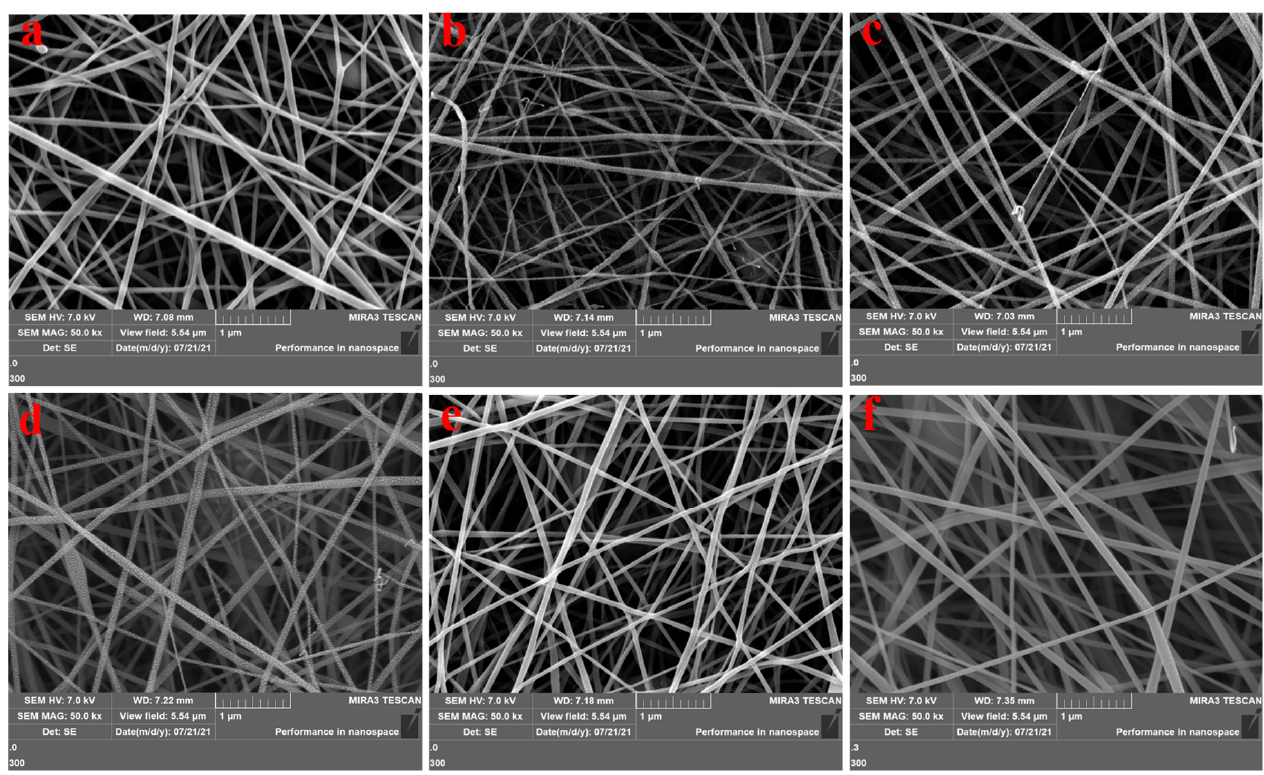
Figure 2. Scanning electron micrographs of flavonoids before sampling of electrospinning membranes ( a ) Chrysin, ( b ) Baicalein, ( c ) Scutellarin, ( d ) Genistein, ( e ) Quercetin, ( f )